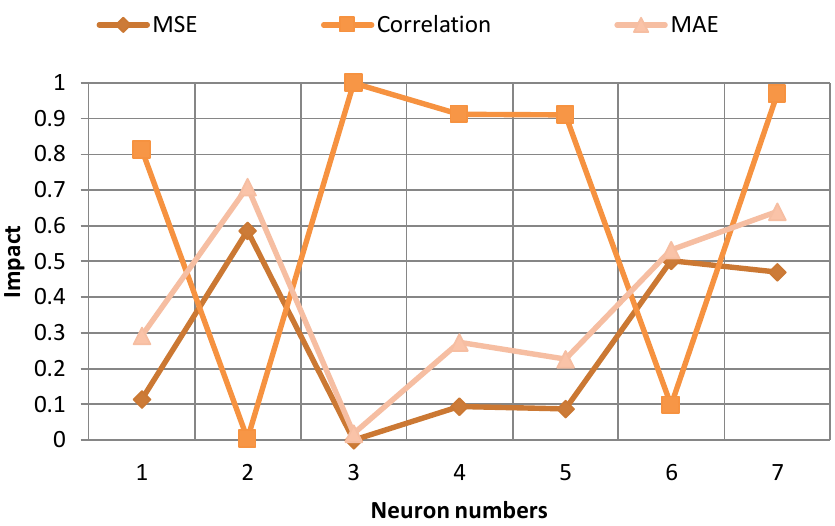
Figure 4. Influence of neuron numbers for test set.